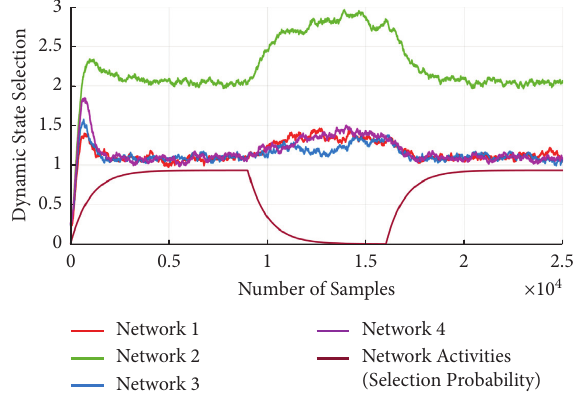
Figure 6: Effect of threshold on network connectivity for � 5 ) sensitivity � 5 ( V thrl